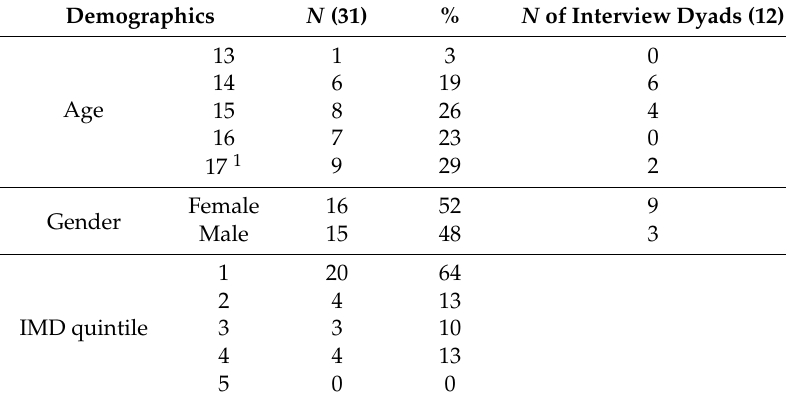
Table 1. Characteristics of